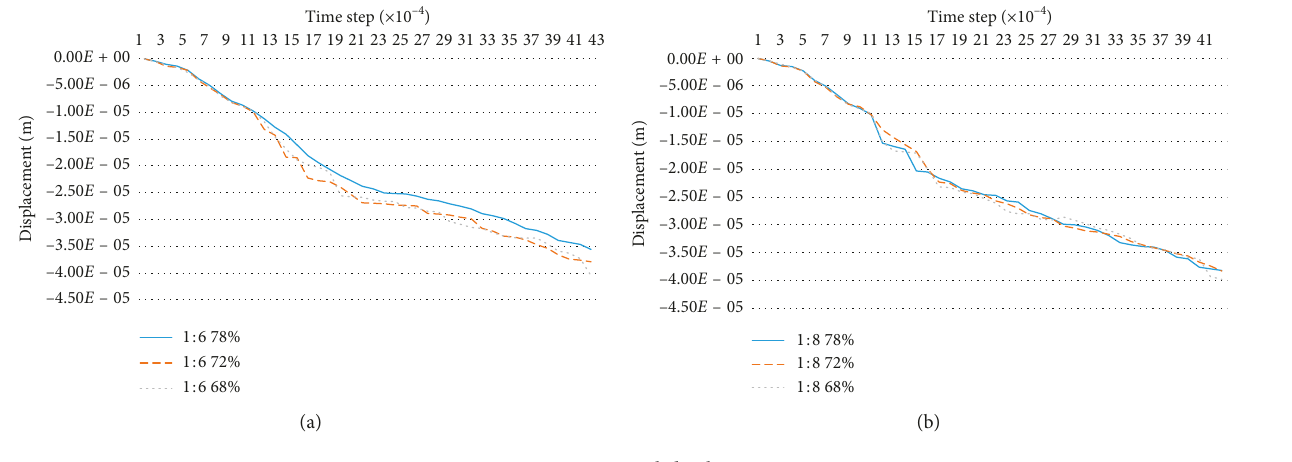
Figure 7: #1 monitoring point vertical displacement-time step curve.